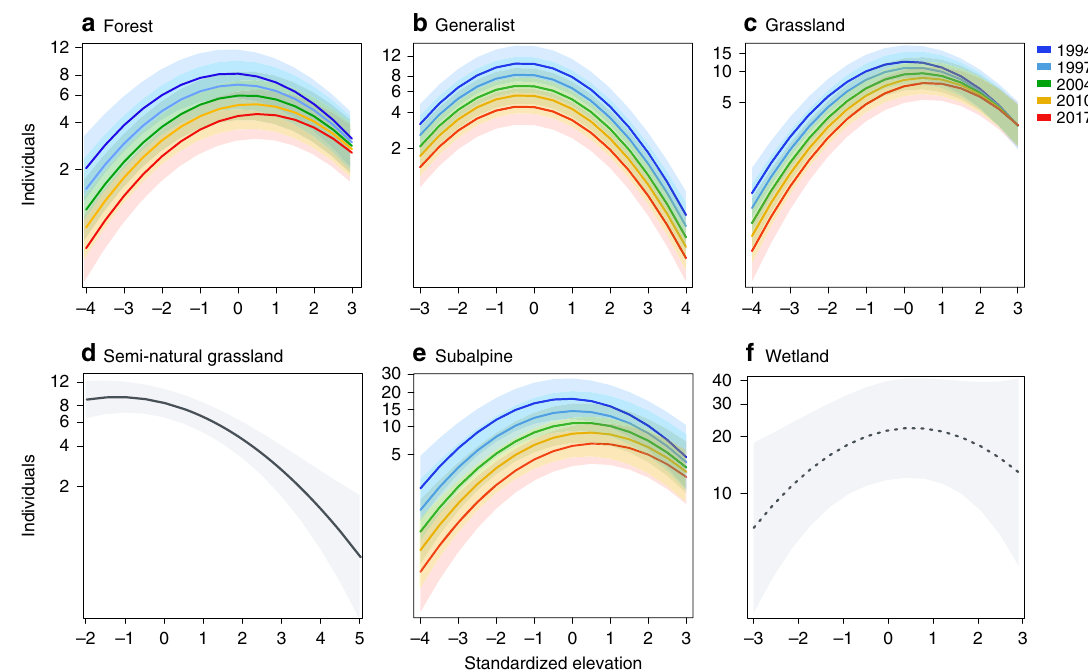
Fig. 5 Temporal trends in orchid population size across species elevational range. Plots depicting the effect of time, elevation (linear and quadratic terms) and, if signi fi cant, their interaction on population size. Separate models were run for different habitat preference categories: a forest, b generalist, c grassland, d semi-natural grassland, e subalpine, and f wetland. Within each species, elevation was standardized to mean 0 and SD 1 to make elevational ranges comparable among species, i.e. the most negative values corresponded to the rear edge and the largest positive values to the leading edge. The relationship for species showing no effect of time is shown in black. For clarity reasons, colour coding shows only 5 years but orchid population size has been recorded over 28 years (1990 – 2017). Shading areas shows 95% con fi dence intervals around model estimates (solid line). For wetland (dashed line), the quadratic effect of elevation was marginal ( p = 0.066, n = 534 observations for 4 species). Plots were drawn using the plotEffect() function in the effects package in R. Partial residuals were not shown due to the large number of data points.